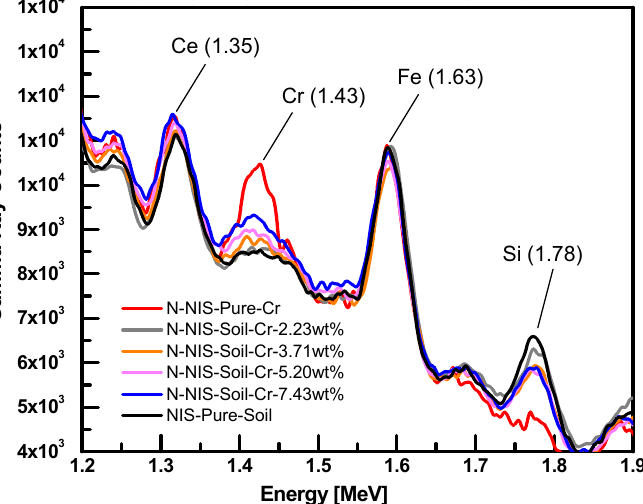
Figure 3. Prompt gamma-ray pulse height spectrum of soil samples containing 2.23, 3.71, 5.20, and 7.43 wt% Cr superimposed upon background spectrum using CeBr 3 detector. The spectrum of a 250 g pure Cr sample overlays the other spectra.